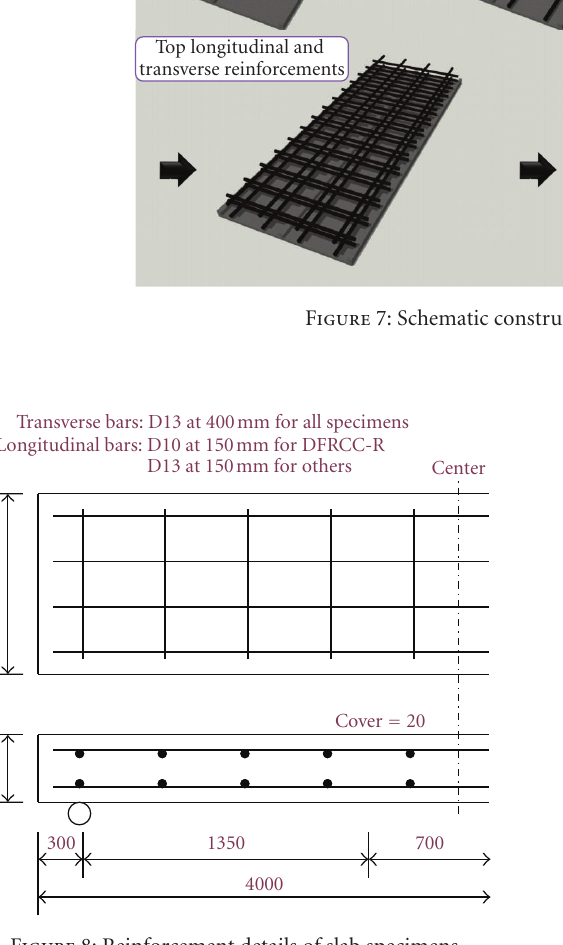
Figure 8: Reinforcement details of slab specimens.